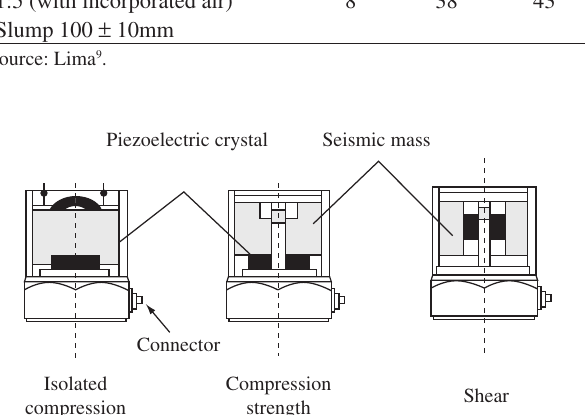
Figure 6. Dosage abacus to determine feature of the HPC for environments at low temperatures. Source: Lima 9 .